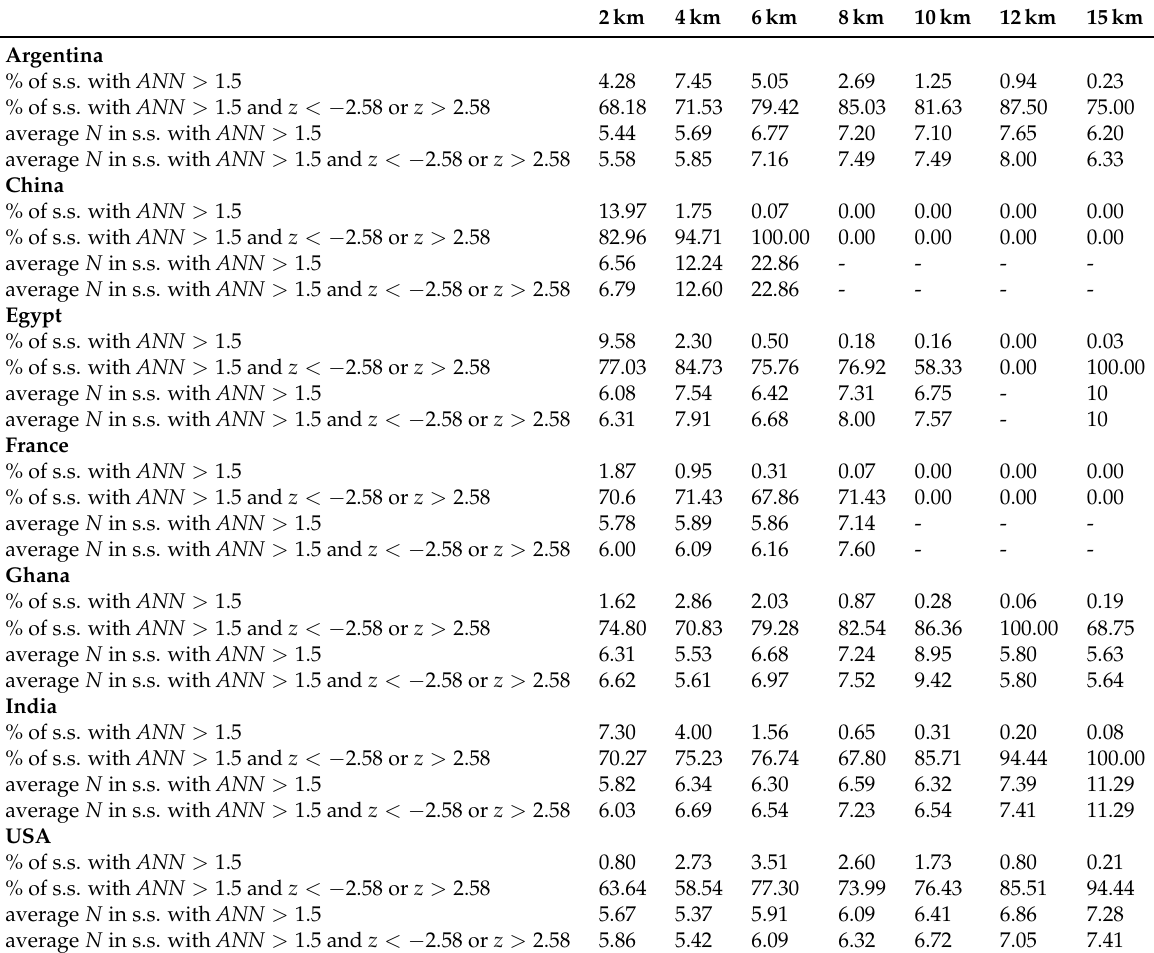
Table A2. Percentage of sample squares (s.s.) with ANN > 1.5 for each data set and the according number of data points N considered to evaluate the ANN > 1.5 in these s.s. Additionally, the percentage of sample squares with ANN > 1.5 and z < − 2.58 or z > 2.58, and the average number of objects N in these sample squares.